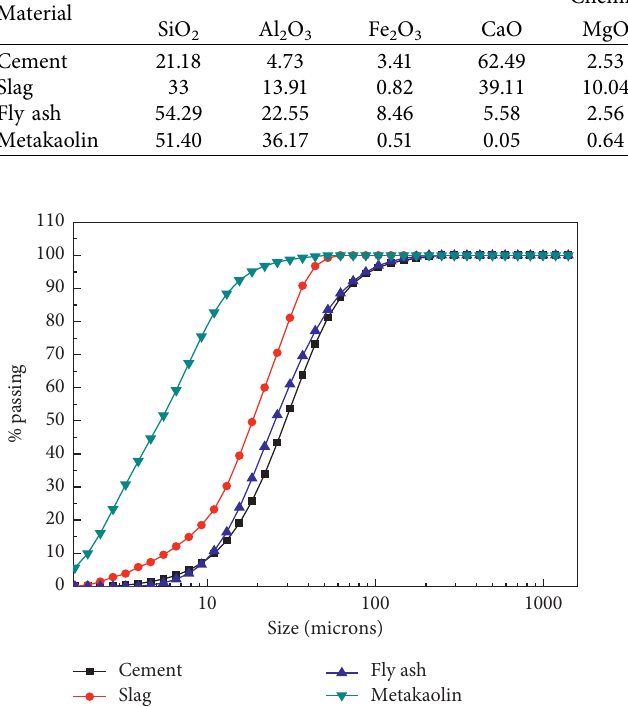
Figure 1: Size distribution of cement, slag, fly ash, and metakaolin.